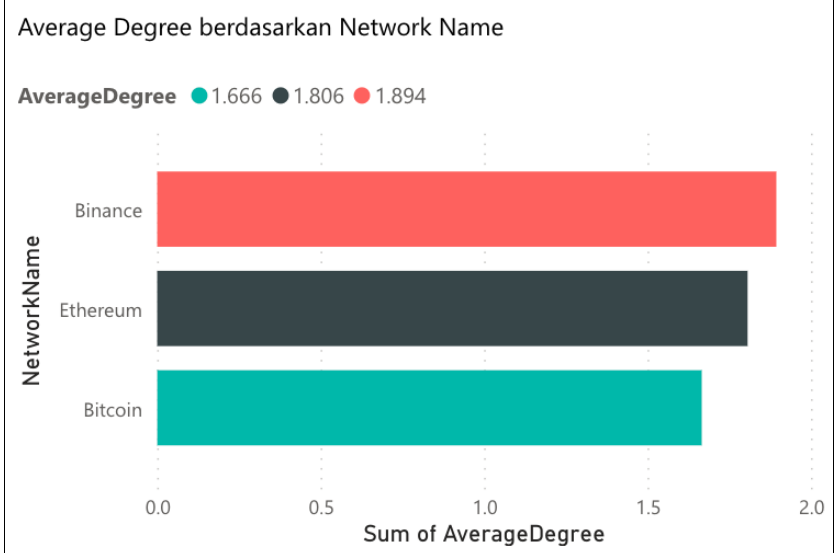
Figure 5(a). Average Degree according to Cryptocurrency